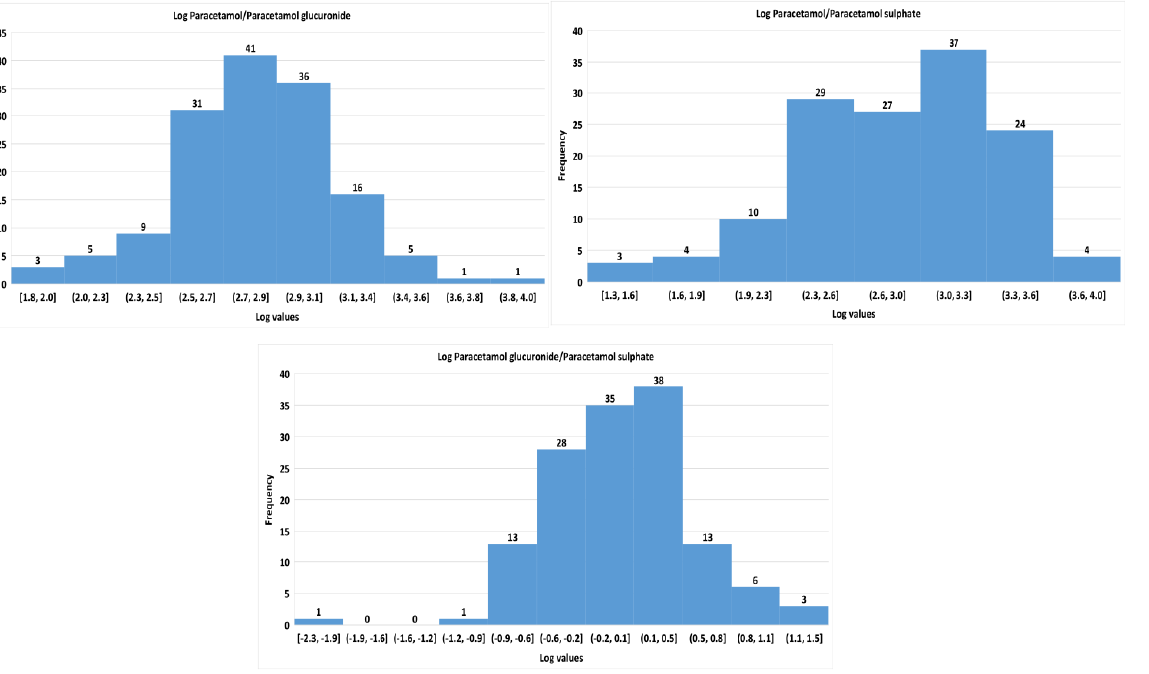
Figure 5. Frequency histogram of the metabolite ratios in the study population. These figures are the frequency histograms of log paracetamol upon paracetamol glucuronide ( top left ), log paracetamol upon paracetamol sulphate ( top right ), and log paracetamol glucuronide upon paracetamol sulphate ( bottom ). The vertical bars indicate the number of individuals observed with the specified log values of the ratios. The distribution looks similar for both paracetamol upon their metabolites while a bimodal distribution was observed for paracetamol glucuronide upon paracetamol sulphate. Table 4. Comparison of serum paracetamol, paracetamol metabolites, and metabolite ratios be- tween those with renal dysfunction and those without. Fifty patients had renal dysfunction. Patients with renal dysfunction were observed with significantly higher concentrations of paracetamol and PG but lower PS (Table 4).